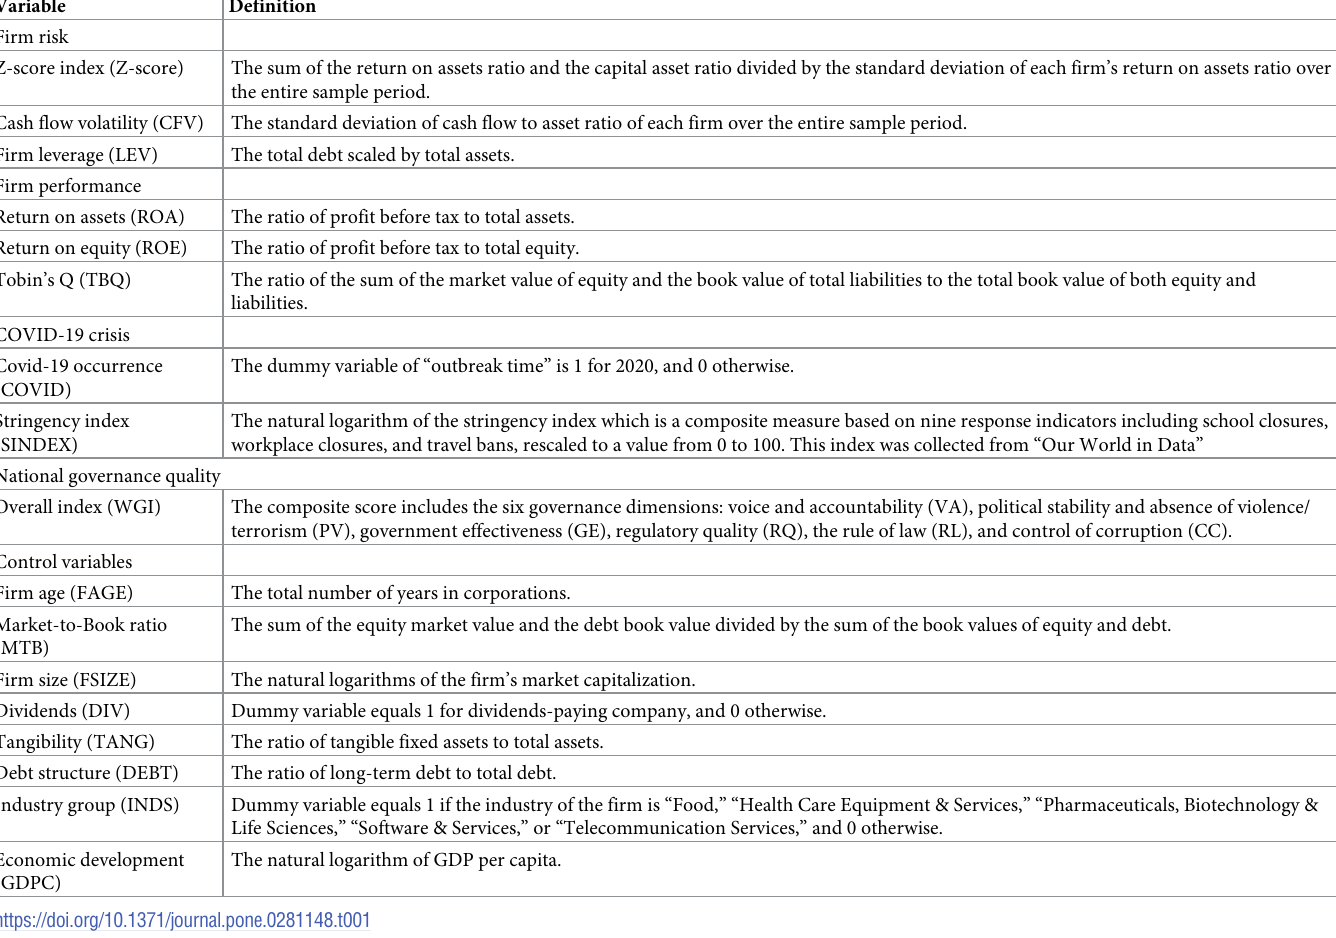
Table 1. Variable